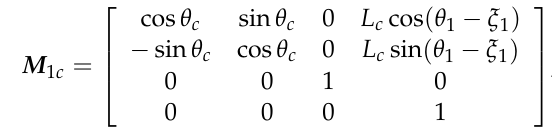
Figure 14. The generating process from the generating gear to the curve face gear pair. The transformation matrix from the coordinate system S c to S 1 is